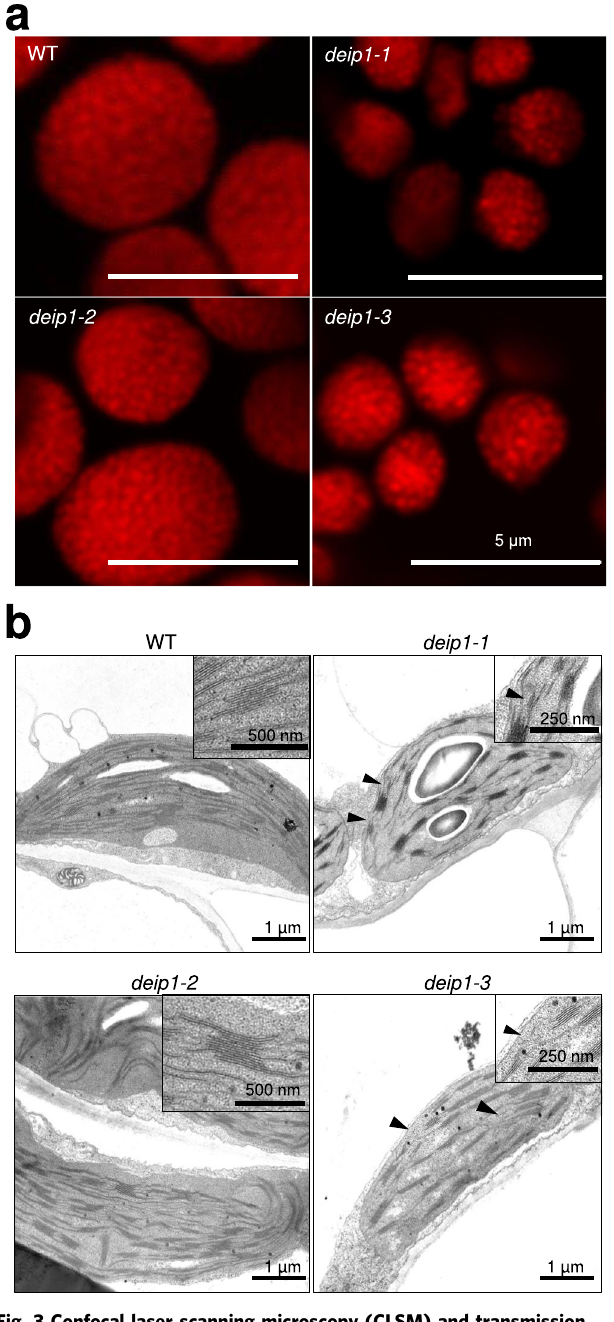
Fig. 3 Confocal laser scanning microscopy (CLSM) and transmission electron microscopy (TEM) images of chloroplasts in the wild type (WT) and the deip1-1 , deip1-2, and deip1-3 mutants. a CLSM images of chloroplasts. The red fl uorescence corresponds to the chlorophyll fl uorescence in chloroplasts of mesophyll cells, the dotted pattern re fl ects the arrangement of grana stacks. Representative images were selected based on observation of 50 chloroplasts per genotype. n = 2 independent biological replicates. b TEM micrographs obtained from chloroplasts of mesophyll cells. The arrowheads mark fork-like structures close to appressed membranes within thylakoids of deip1-1 and deip1-3 . Representative images were selected based on observation of 15 chloroplasts. n = 2 independent biological